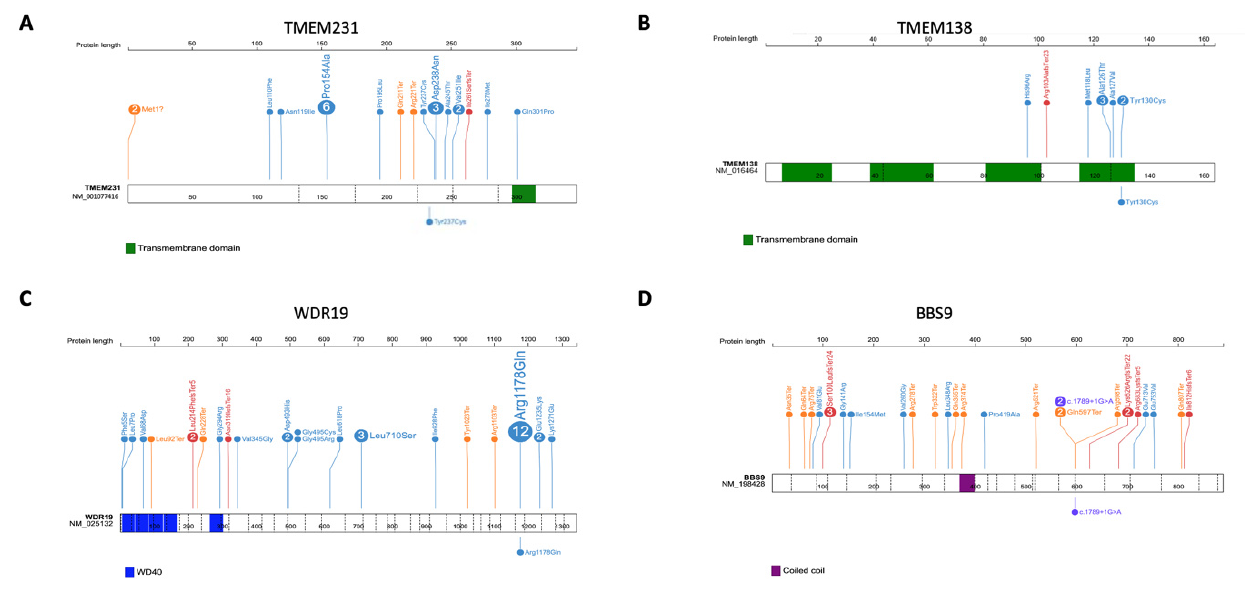
Figure 2. Distribution of mutations in TMEM231 , TMEM138 , WDR19 and BBS9 . Positions and the predicted protein alterations are shown for A . TMEM231 B . TMEM138 C . WDR19 D . BBS9 . Exon structure is marked by a dashed line. Protein domains are shown in colored bars. Known mutations are shown above the gene/protein structure with the number showing frequency (if >1) of probands reported for each mutation. Mutations identified in this study are shown below the gene/protein